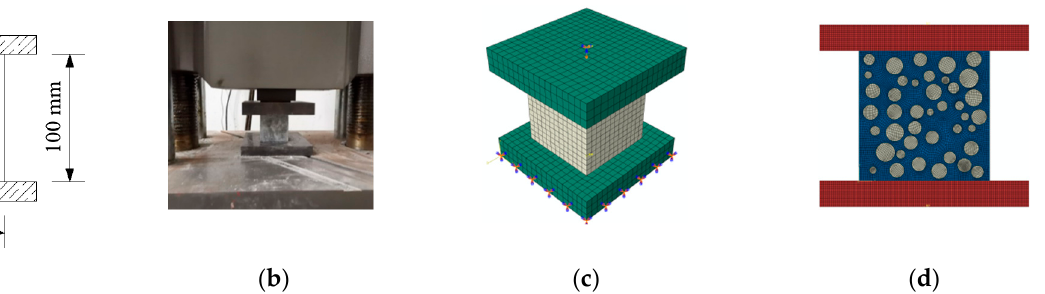
Figure 4. Cubic compressive strength test: ( a ) schematic design, ( b ) physical diagram, ( c ) inclusion model, and ( d ) 2D random model.